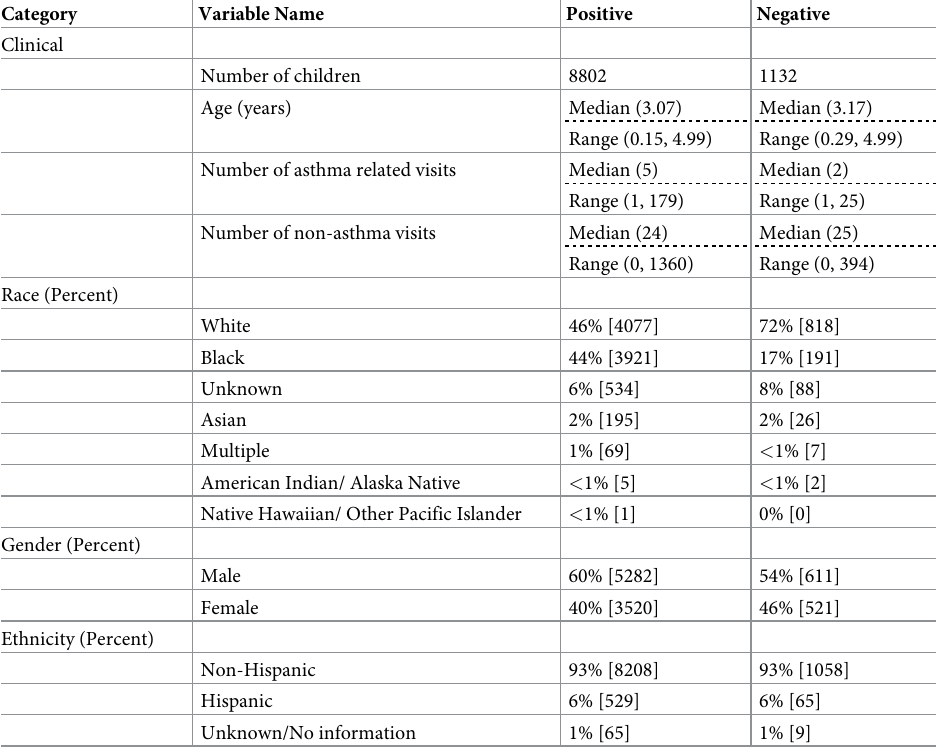
Table 1. Study cohort demographics at the time of first asthma diagnosis.